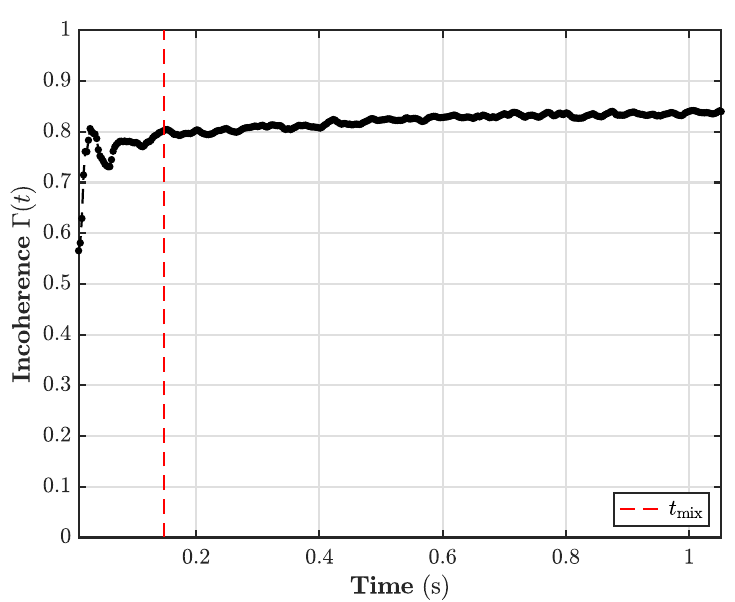
Figure 7. Spatial incoherence analysis for the DRIR measured in the neo-Gothic chapel at the Dominicans of Haute-Alsace cultural centre and former convent. Mathematical expectations are estimated by averaging over short-term Fourier transform frames for a total window length of 40 ms. The mixing time t mix is estimated algorithmically by identifying the maximum incoherence reached after the period of initial instability due to the arrival of coherent early reflections. Note the gradual increase in incoherence throughout the reverberation tail due to the increasing influence of the background noise